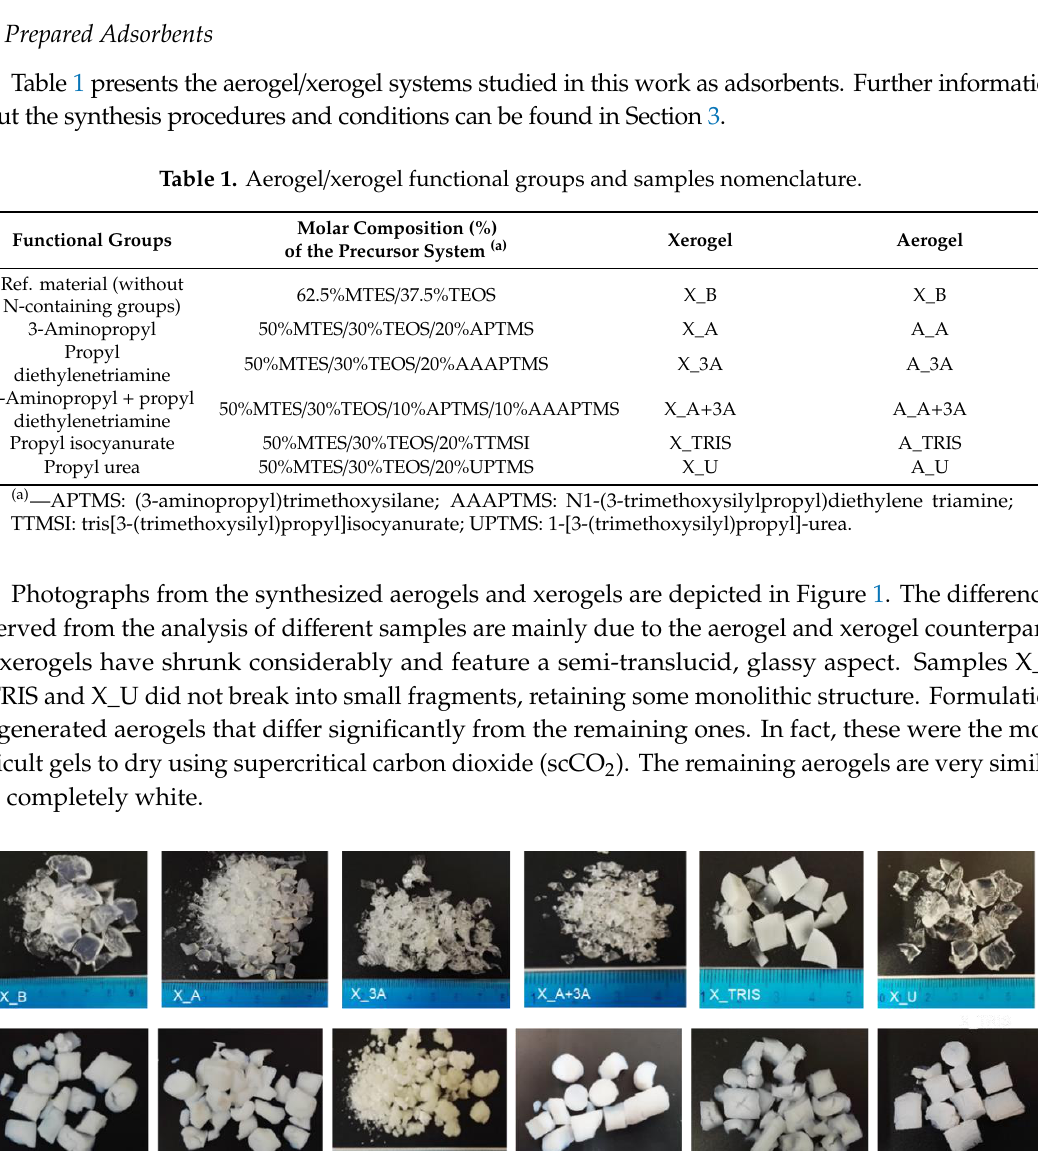
Table 1. Aerogel/xerogel functional groups and samples nomenclature.